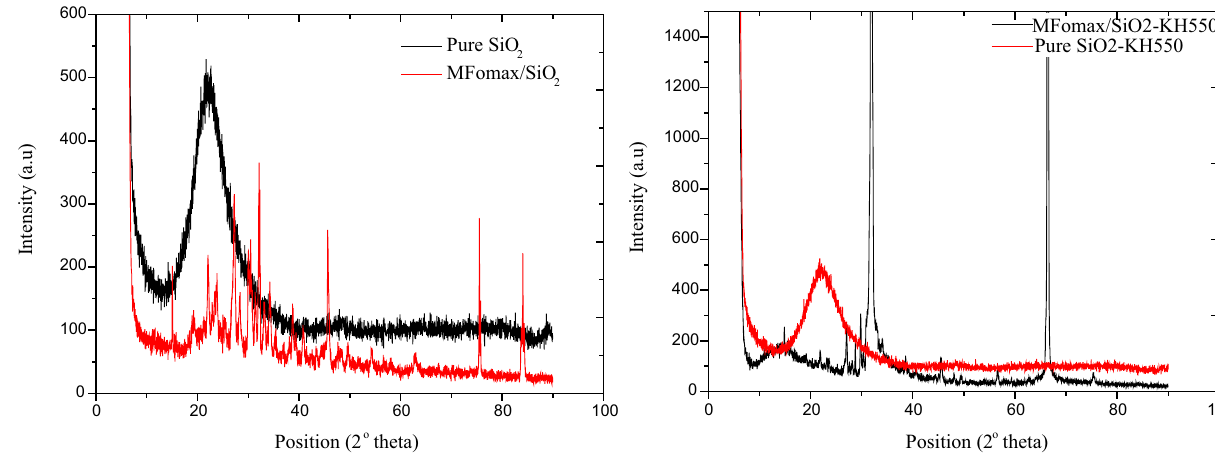
Fig. 11 Comparison of the XRD spectroscopic of the pure NPs and the NFs materials